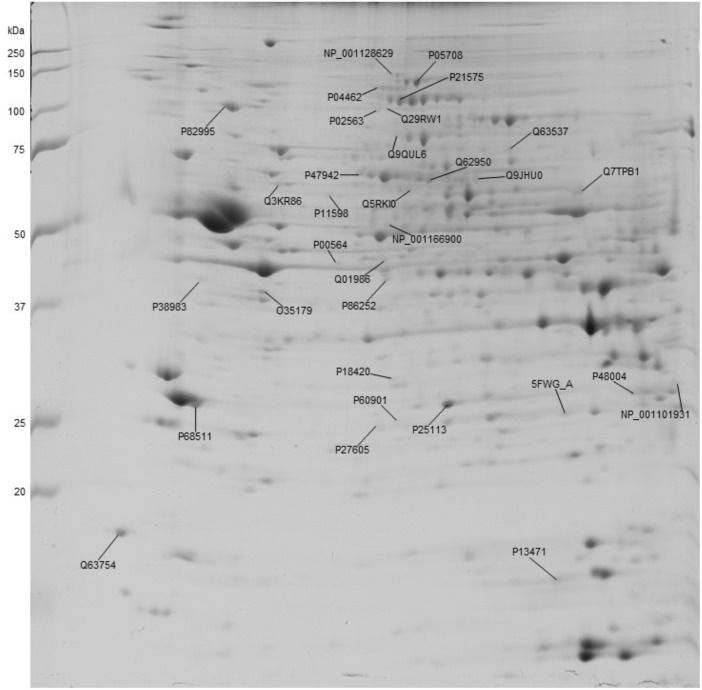
Representative image of a 2DE gel of a control (vehicle) dorsal hippocampal formation depicting the proteins that were significantly affected by EGb treatment. The numbers indicate the protein accession number.